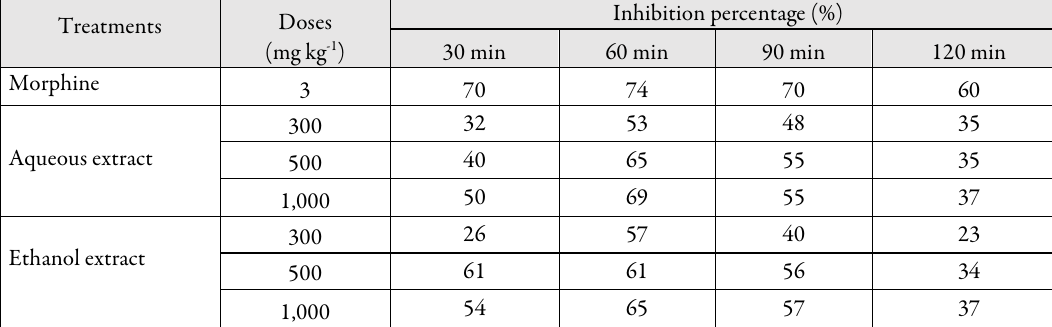
Table 4. Pain inhibition percentage for different treatment types in the tail flick